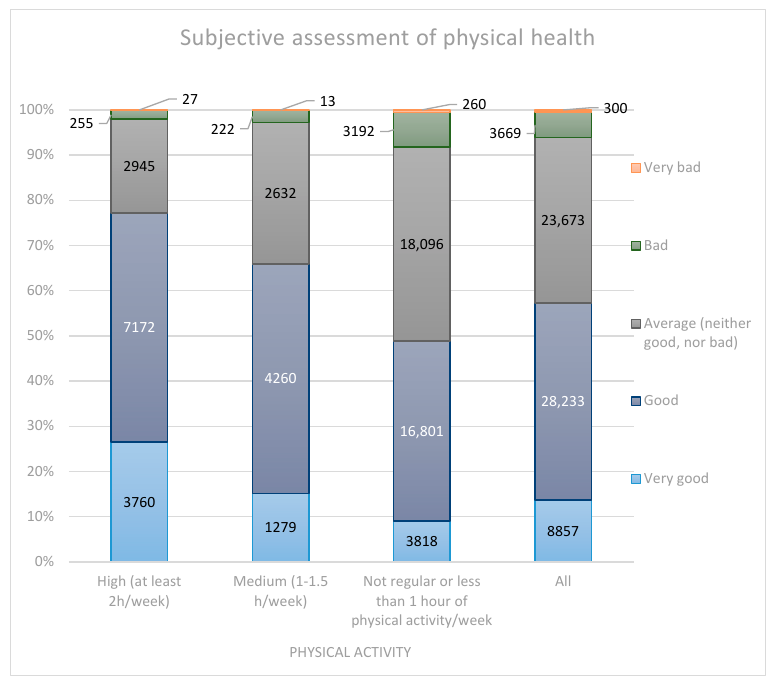
Figure 2. Subjective assessment of physical health. Subjective psychological health was rated as “very good” by 41.2% of respondents from the most active group, 33.1% from the medium group and 27.4% from the least active group ( p < 0.001), as can be observed in Figure 3. “Average” psychological health was reported by 20.8% of respondents from the least active group but only 11.8% from the most active group ( p < 0.001).